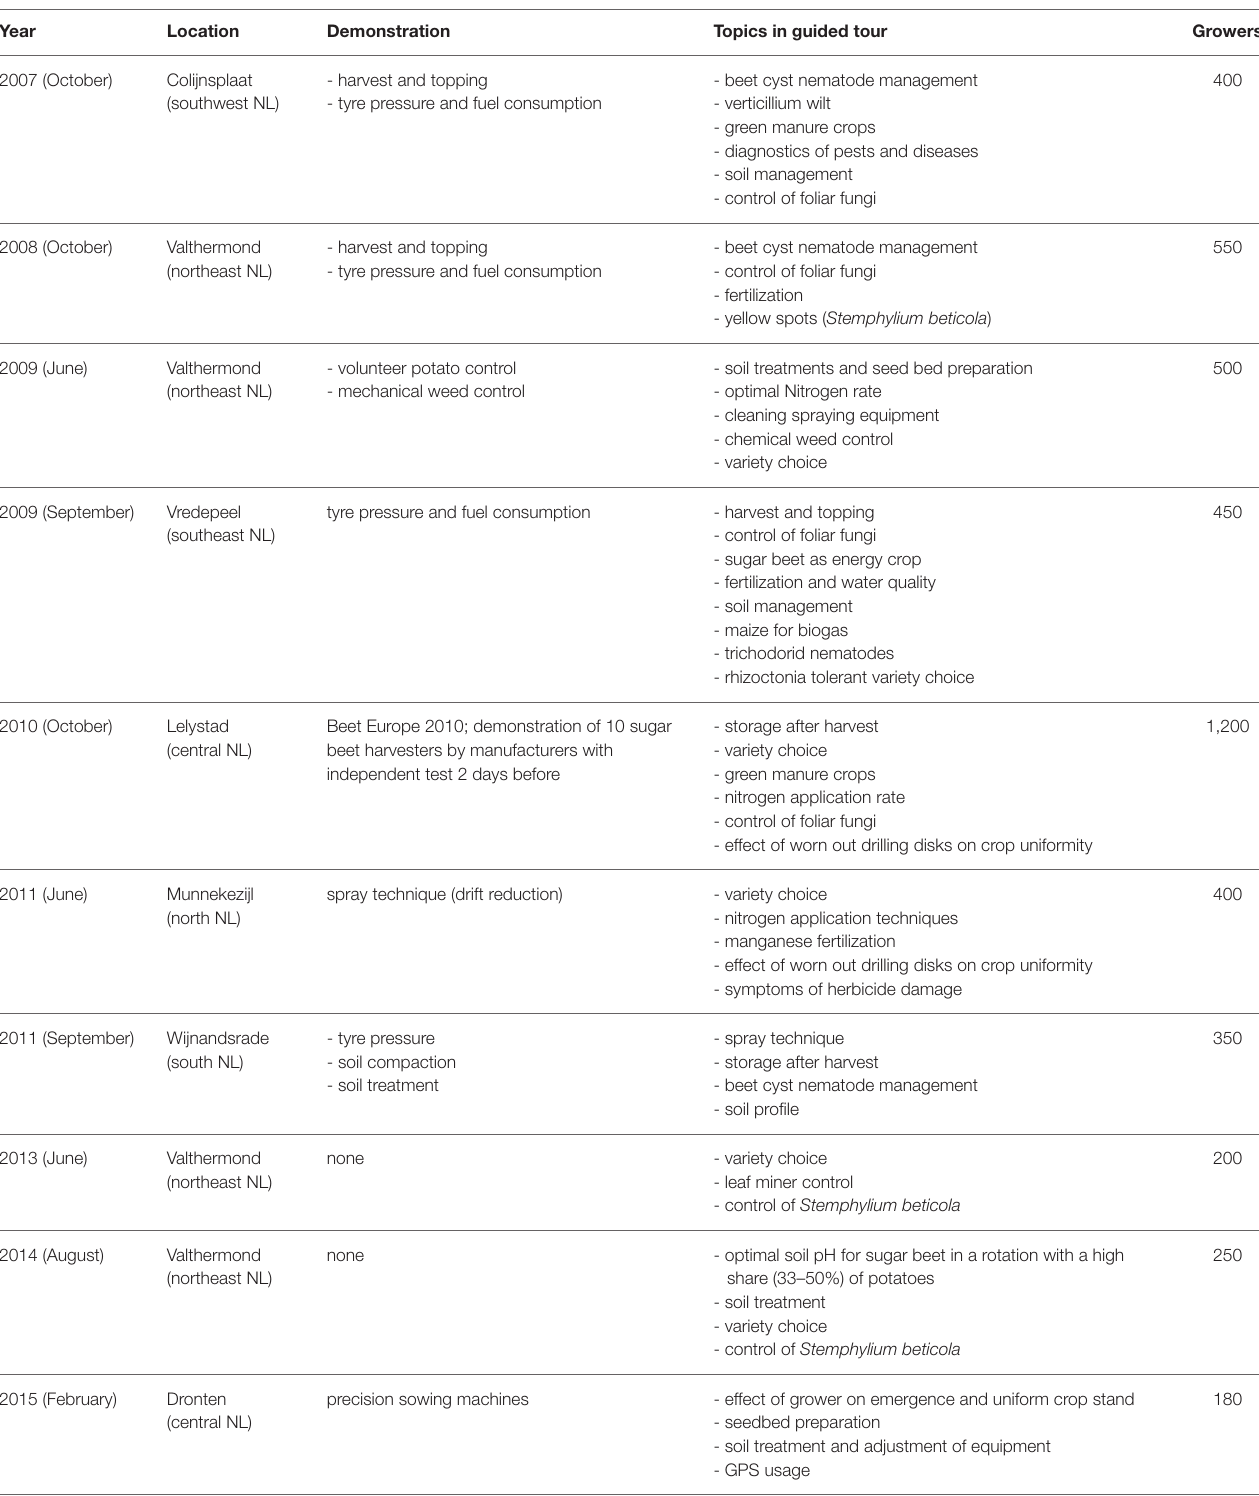
TABLE 4 | Field days on sugar beet growing organized in the Netherlands